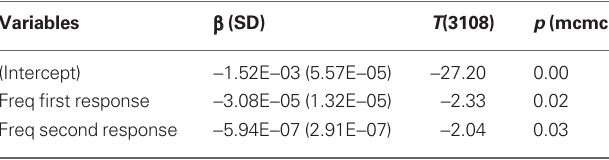
Table 1 | Beta (standard error), t (degrees of freedom), and p -vales for the fixed effects in the linear mixed effect analysis.